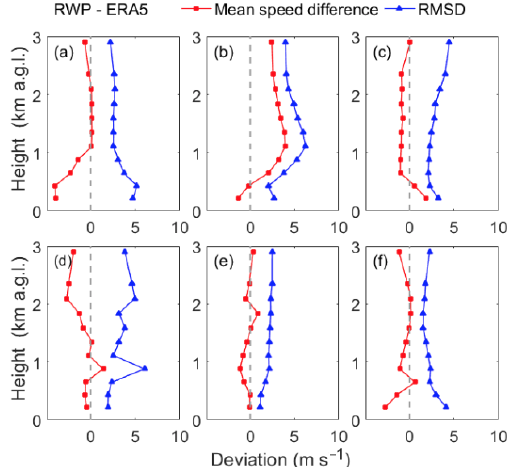
Figure 6. Comparison results between RWPs and ERA5 at six RWP stations: (a) Beijing (40 ◦ N, 116 ◦ E), (b) Wulumuqi (43 ◦ N, 87 ◦ E), (c) Chongqing (30 ◦ N, 106 ◦ E), (d) Shanghai (31 ◦ N, 121 ◦ E), (e) Zigui (31 ◦ N, 111 ◦ E) and (f) Haikou (20 ◦ N, 110 ◦ E). The grey, red and blue lines represent the reference line, mean speed difference and root-mean-square difference (RMSD),